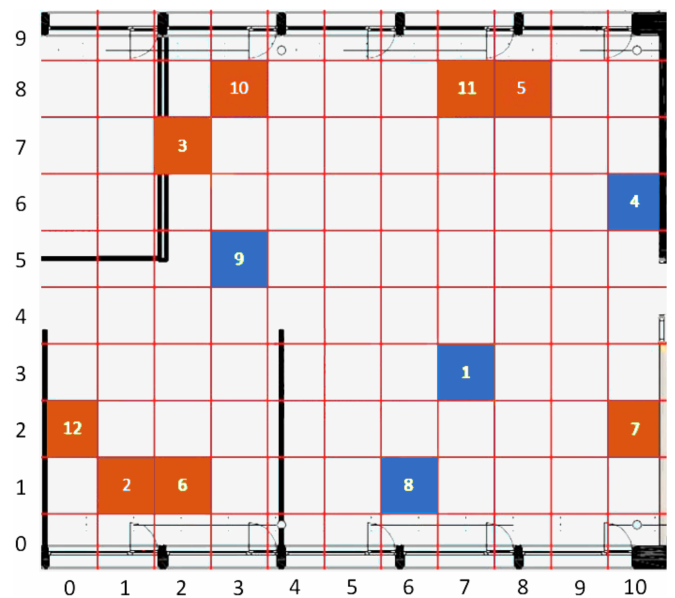
Figure 1. Location of the sensors in the considered premise. The blue cells represent the reference sensors that will be selected during the sensors selection phase.